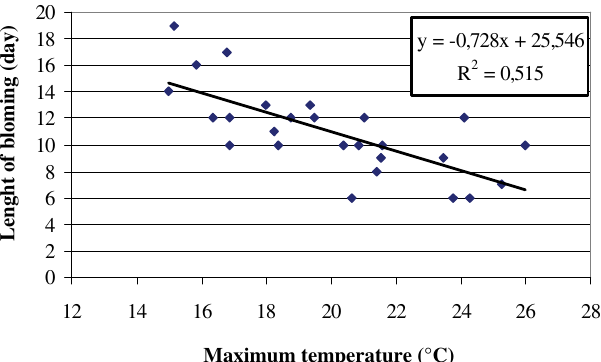
Figure 9. Relationship between the lenght of blooming and average value of maximum temperature during the bloming at “Debreceni bôtermô”